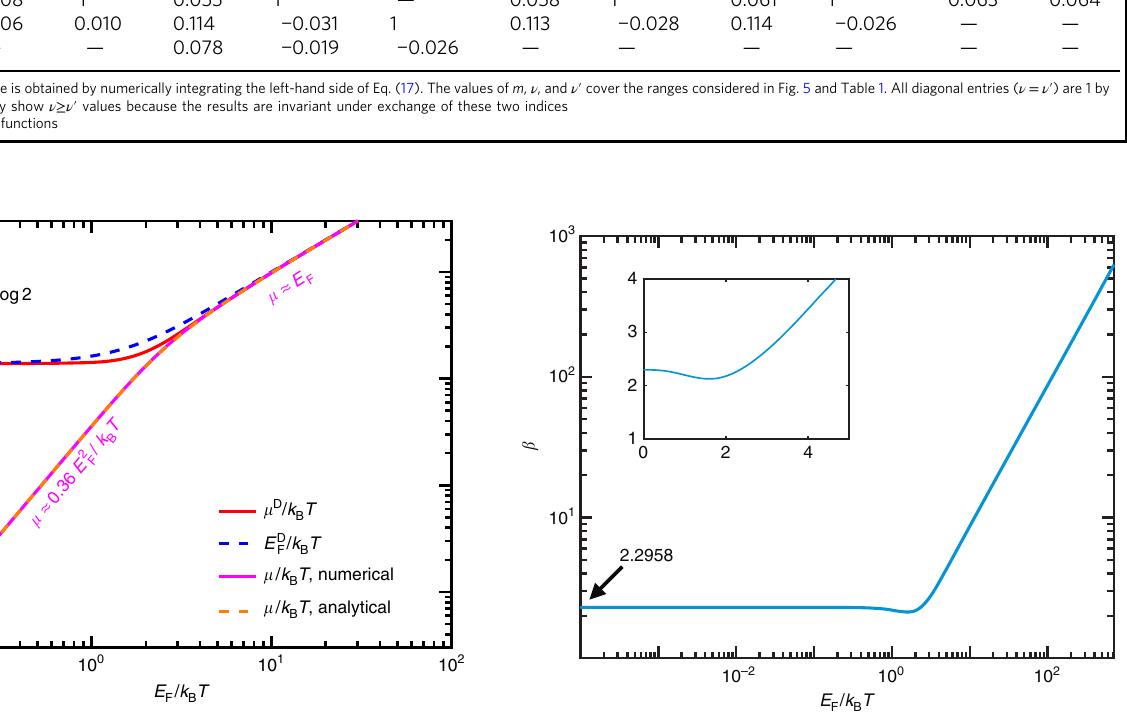
Fig. 6 Graphene chemical potential and Drude weight. We show the Fig. 7 Graphene electronic heat. We show the dependence of the thermal relation between the chemical potential μ and the Fermi energy E F in coef fi cient β on E F / k B T , as calculated from Eq. (24). This parameter permits graphene, both of them normalized to k B T . The direct numerical solution of obtaining the electronic heat per unit of graphene area as β ð k B T Þ 3 = ð (cid:1) hv F Þ 2 Eq. (20) ( pink solid curve ) is nearly indistinguishable from the analytical [Eq. (23)]. The inset shows β in linear expression of Eq. (21) ( dashed orange curve ). For completeness, we also plot the normalized Drude weight μ D / k B T [ red solid curve , see Eq. (26)] and an = k approximate Drude weight E D B T ( dashed blue curve ) F following approximate relation